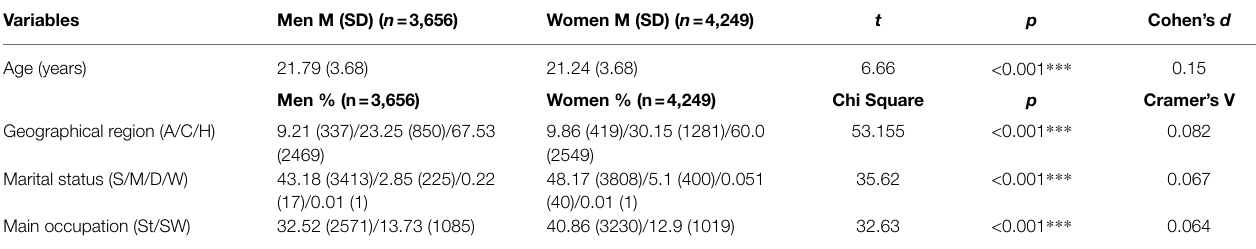
TABLE 1 | Gender differences in sociodemographic variables.